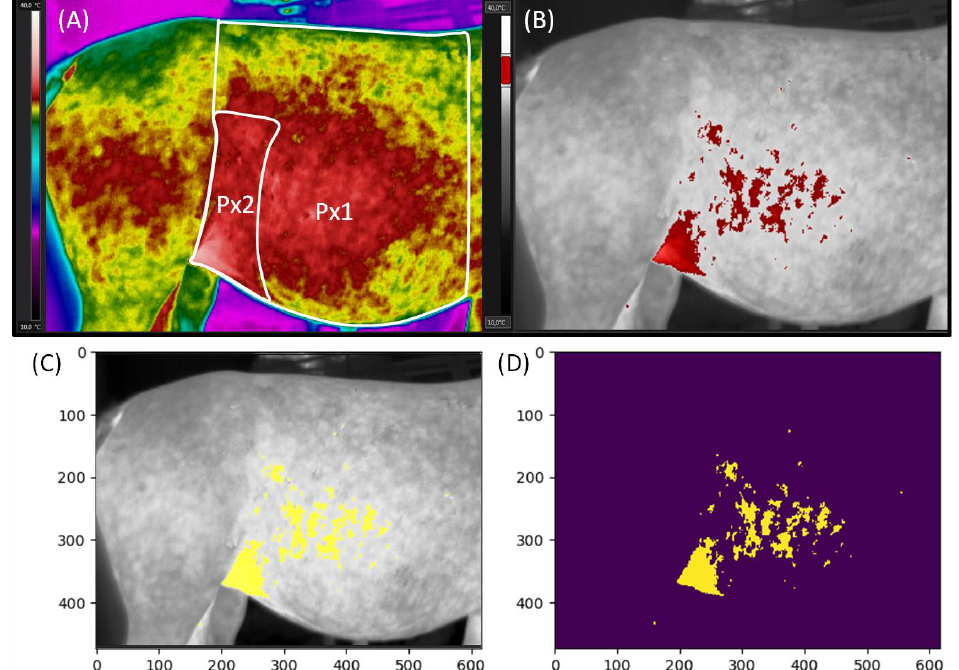
Figure 1. Thermal images of the lateral surface of the abdomen of the pregnant mare. Rainbow HC palette with marked Px1 and Px2 ( A ). Gray palette with red annotated areas at a certain temperature ( B ). Gray palette with yellow annotated areas at a certain temperature in the pixel counting procedure ( C ). The counted pixels with non-zero value ( D ). Abbrevi- ations: Px1, the whole area of the lateral surface of the abdomen; Px2, the flank area of the lateral surface of the